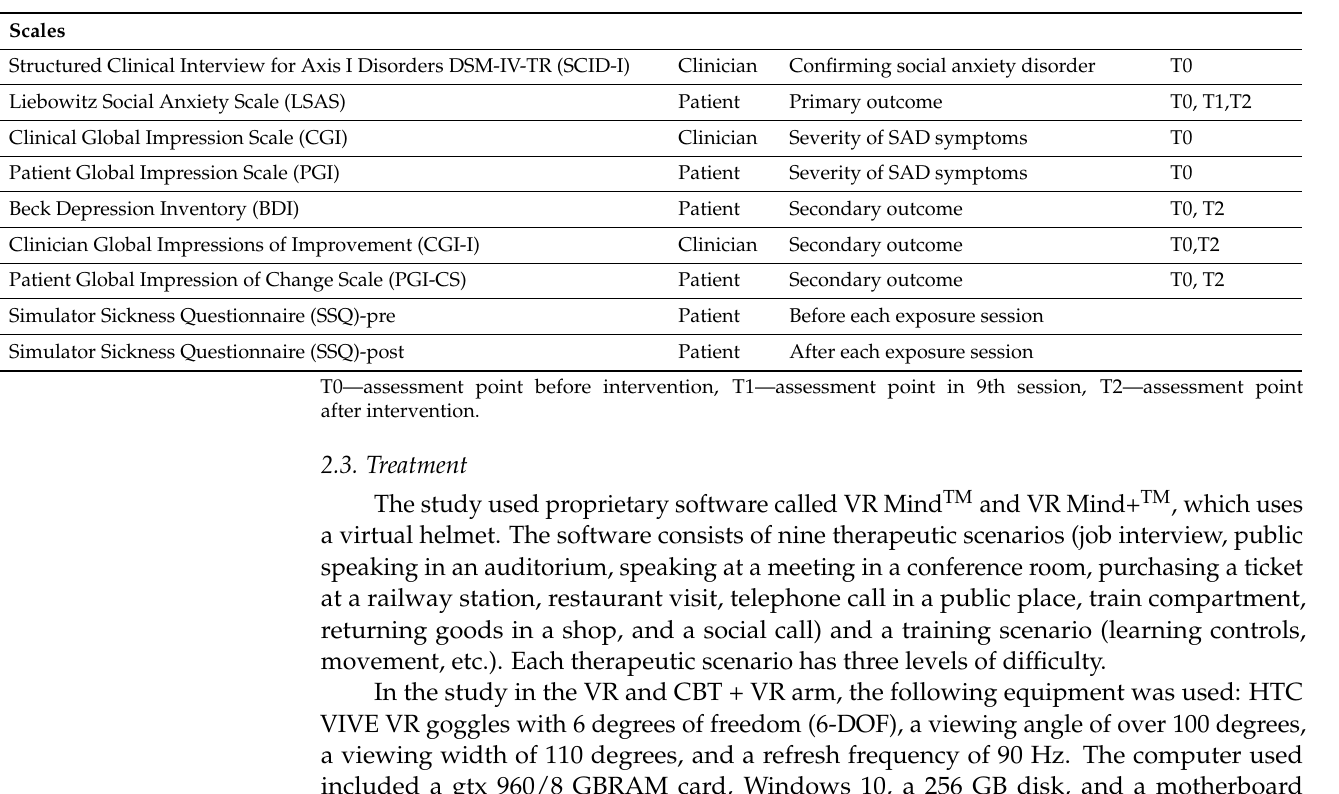
Table 2. Measures used in the